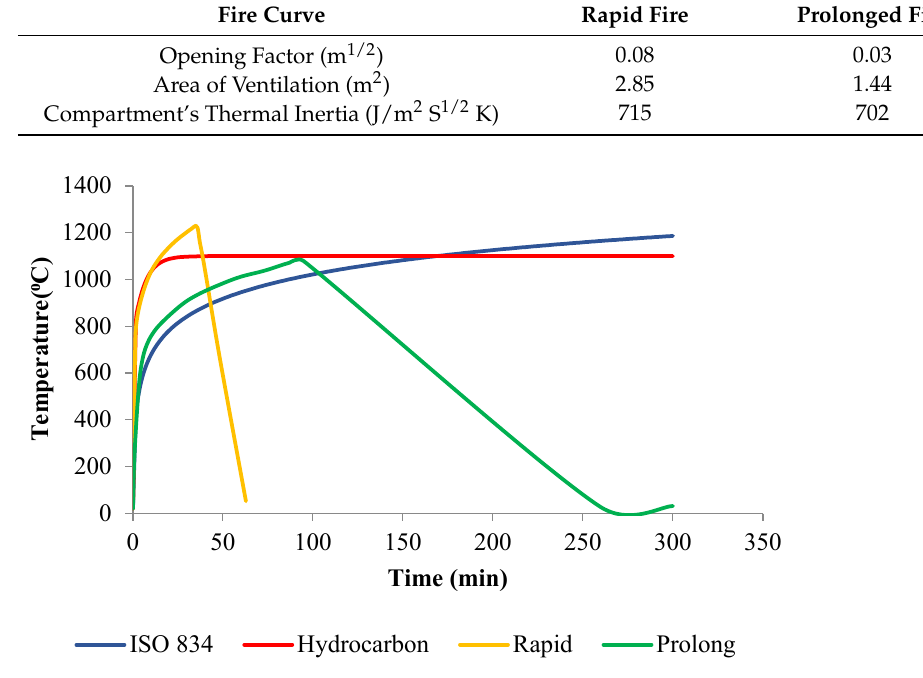
Figure 7. Standard fire (ISO 834) and real fire curves.